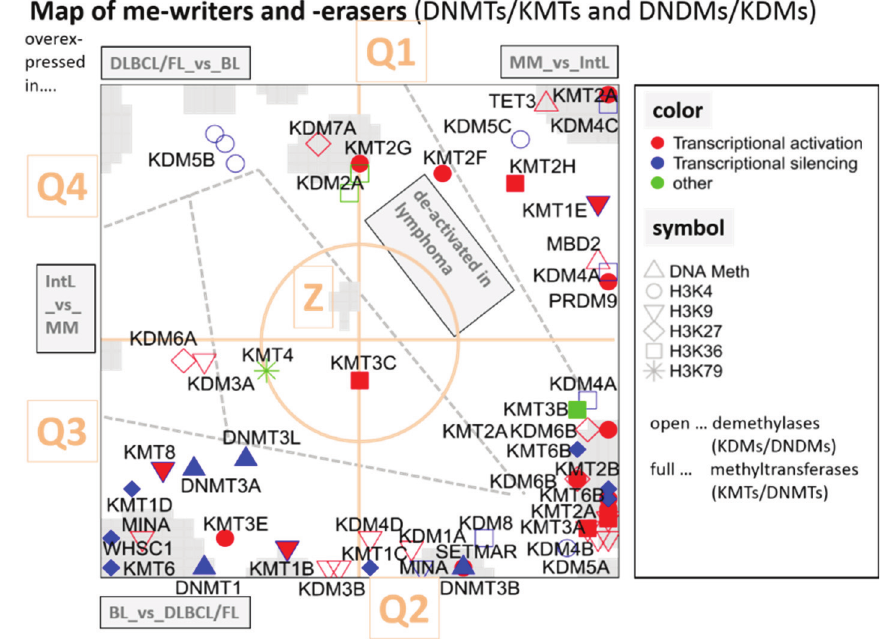
Figure 5. Mapping of writers and erasers of epigenetic methylation marks into the gene expression landscape (DexSOM) of lymphoma. The map is segmented into regions of specific differential expression between the lymphoma classes by dashed lines. The mode of differential expression is indicated in the grey boxes (e.g., “IntL_ vs. _MM” contains genes upregulated in IntL compared with MM). So-called spot-clusters of differentially expressed genes are grey-colored. The map is further divided into four quadrants Q1–Q4 and a central region “Z” (see Figure 2 for segmentation of the SOM). Epigenetic modifiers are labeled as shown in the right part of the figure. A few genes are redundant because more than one probe set interrogate them (e.g., KDM4A, KDM6B, KMT6B). The redundant probe sets